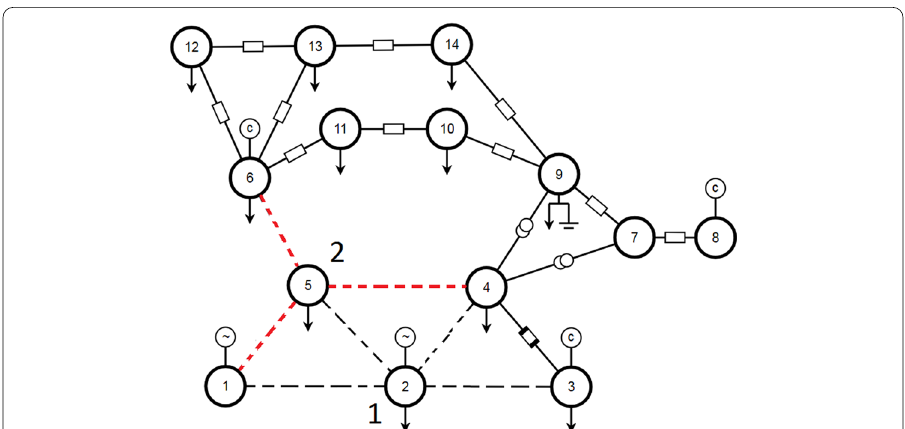
Fig. 2 IEEE 14-bus power system representation of the IMCE fault profile The transmission lines disconnected after the removal of buses are identified (dashed lines)